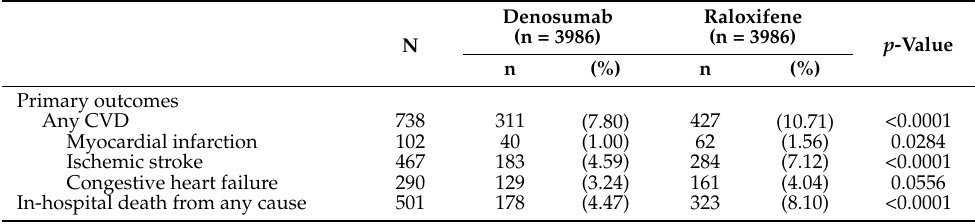
Table 2. The major adverse cardiovascular outcomes in the denosumab and raloxifene groups.